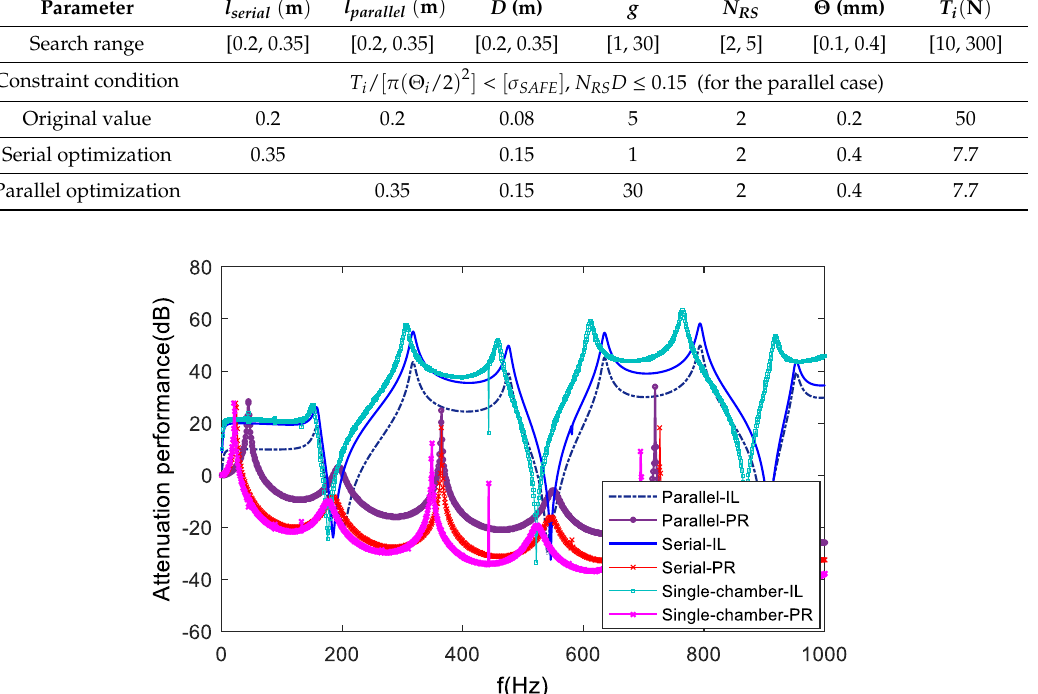
Figure 13. Wide-band optimization for serial and parallel combinations of RSHPA.